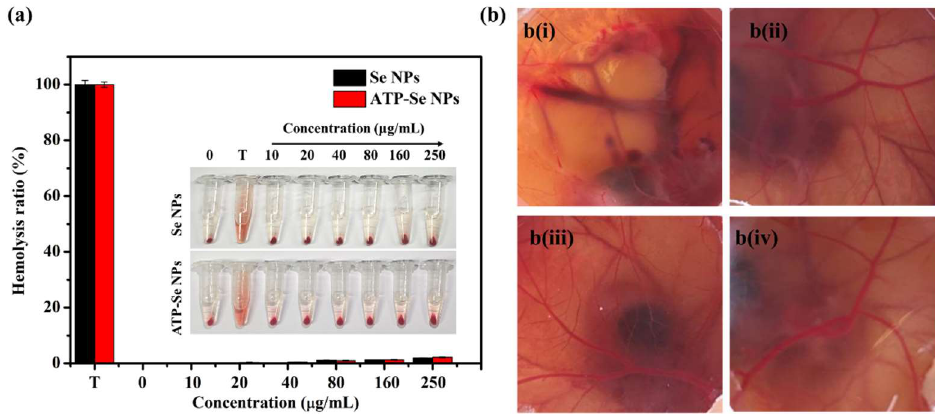
Figure 9. Hemolysis activity of ATP-SeNPs, Triton X-100 (T); insert image is of hemolysis observa- tion image ( a ). Chick chorioallantoic membrane assay ( b ). NaOH (1 M; b i ), PBS ( b ii ), SeNPs ( b iii ), and ATP-SeNPs ( b iv ).